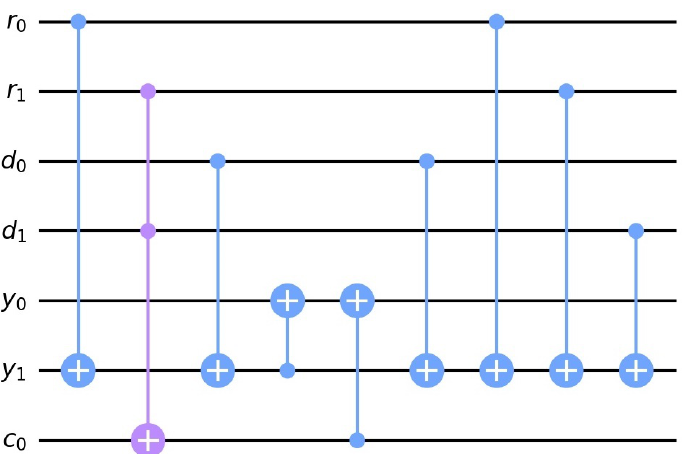
Figure 17. Circuital schema of the mod -4 adder. The position index ( r 0 , r 1 ) is added to the correspond- ing decoded displacement ( d 0 , d 1 ) (as of expression (19)) to get to the updated position index ( y 0 , y 1 )